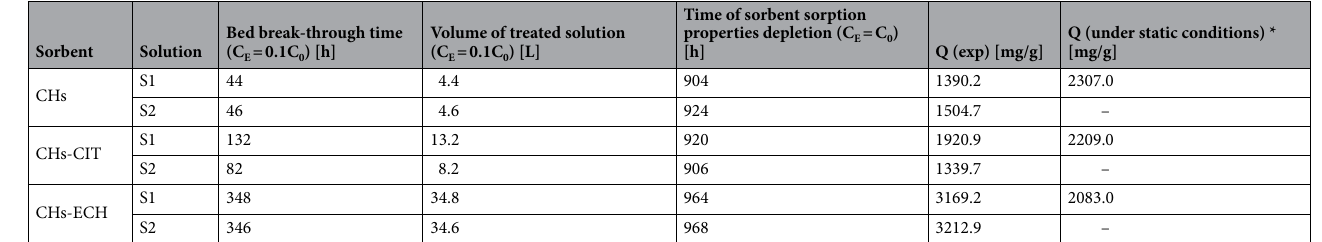
Table 4. Work parameters of a system with the air-lift reactor depending on the chitosan sorbent used and treated solution type. *Based on the our previous study 10 .